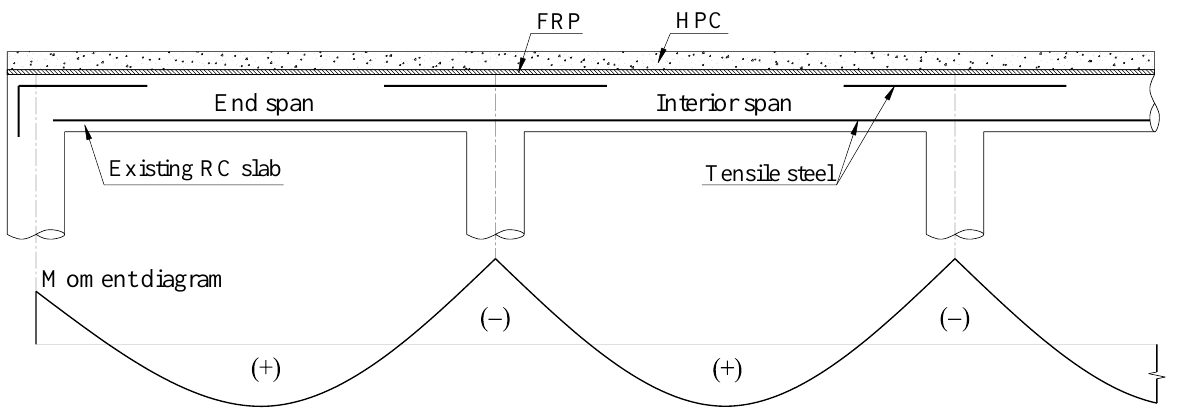
Figure 1. The existing RC slab with an HPC-FRP retrofit system.